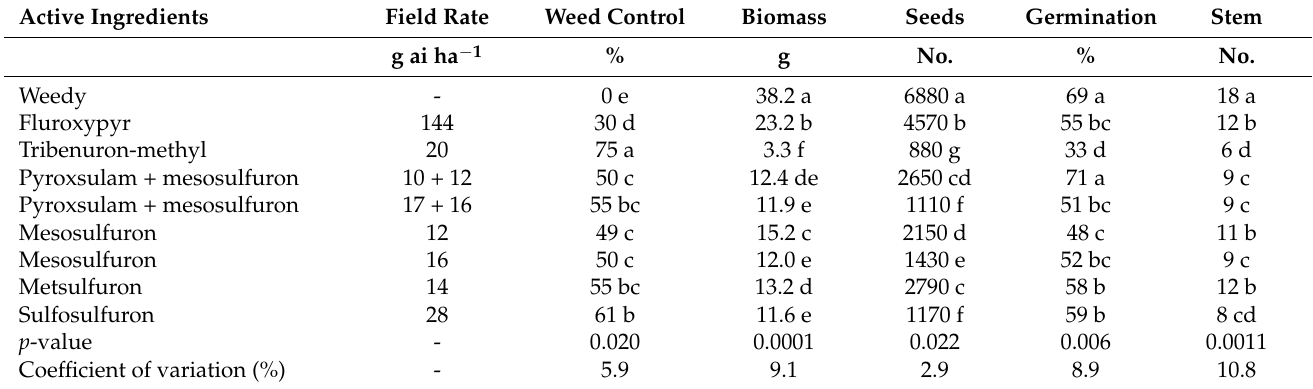
Table 5. Wild mustard control in different aspects in each plot, 28 days after treatment combined across regions. Active